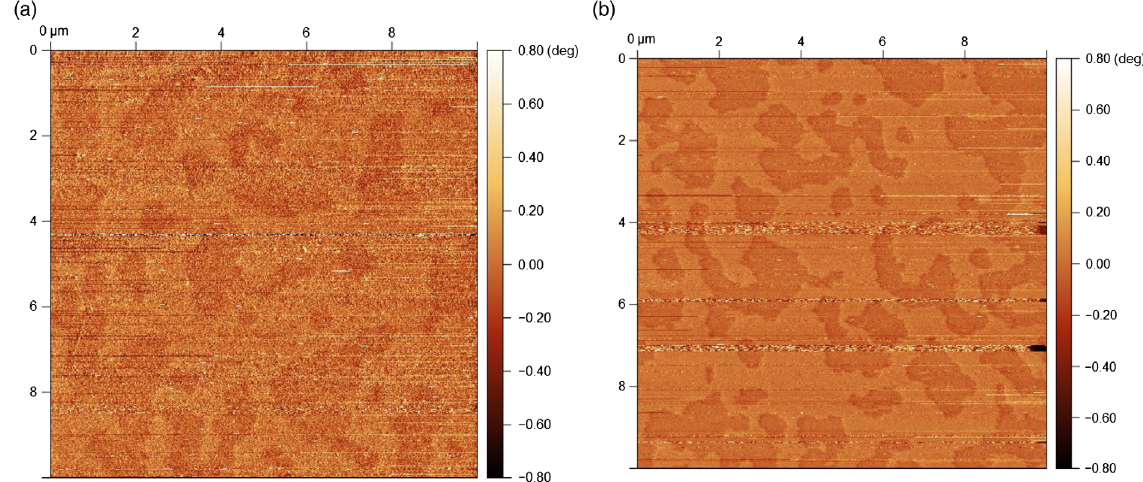
FIG. 5. Magnetic force microscopy (MFM) images of Pt ð 2 . 0 nm Þ = Co ð 1 . 1 nm Þ = Pt ð 1 . 7 nm Þ = Nb ð 30 nm Þ (a) and Pt ð 2 . 0 nm Þ = Co ð 1 . 5 nm Þ = Pt ð 1 . 7 nm Þ = Nb ð 30 nm Þ (b), taken at the remanent state at 300 K. The measured maze patterns of magnetic domains with a broad periodicity (a few microns) indicate a weak Dzyaloshinskii-Moriya interaction and the absence of magnetic Skyrmions in our Pt = Co = Pt symmetric structures, which are well consistent with previous experiments [22,23]. Note that for the Co thickness t < 1 . 1 nm, the MFM contrast is below the noise level of our Co